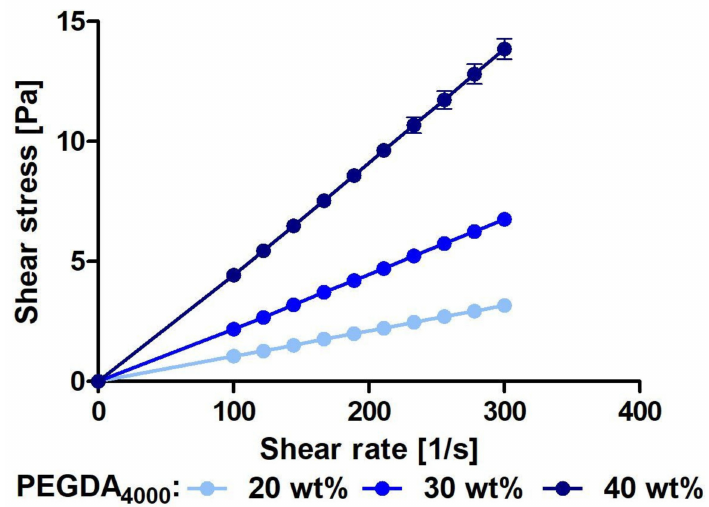
Figure 1. Exemplary shear stress/shear rate representation of PEGDA 4000 solutions in H 2 O/MeOH (1:2) with different concentrations of the polymer at 15 ◦ C (n = 3).